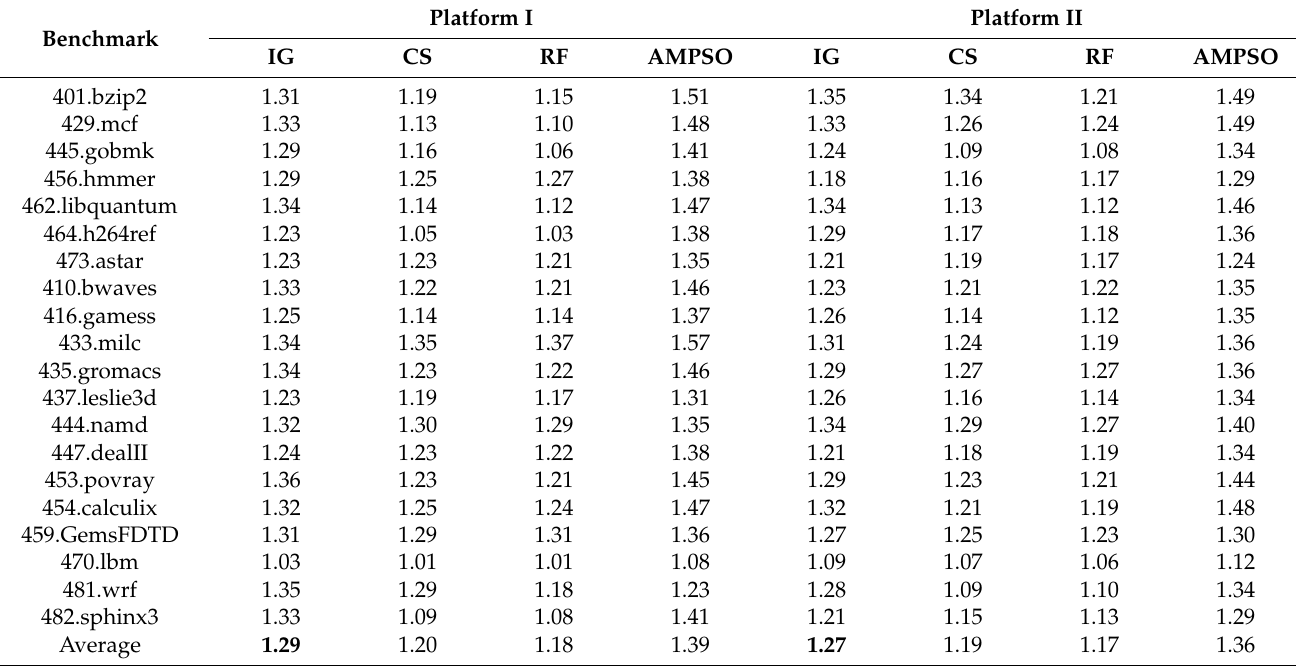
Table 3. Running time while using different features.